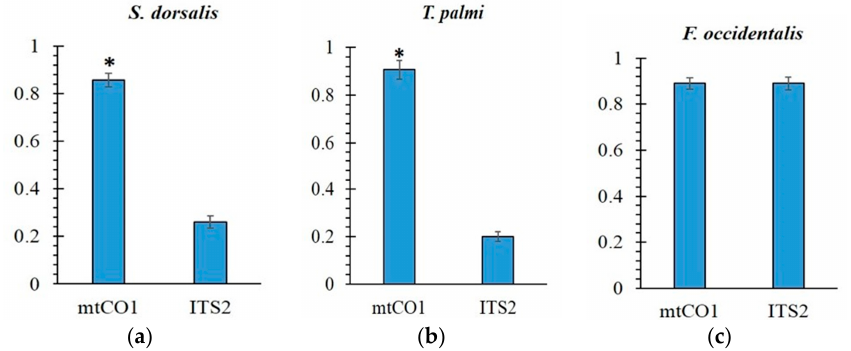
Figure 1. Frequency ( Y -axis) of the most common sequence (a proxy for the likelihood of obtaining